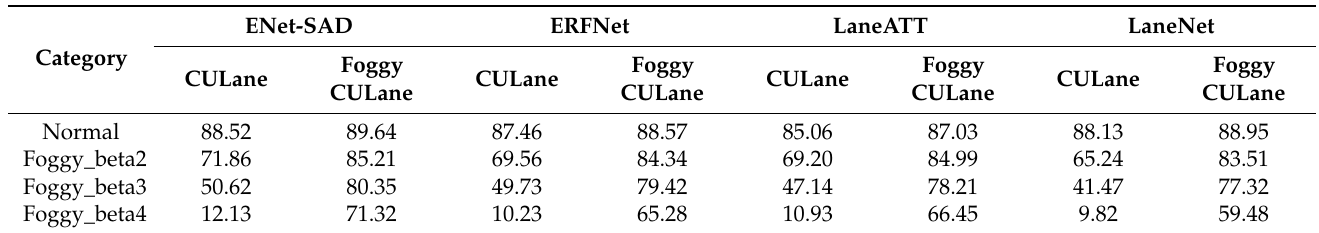
Table 4. Evaluation results (F1-measure) of other lane detection models, trained with CULane and FoggyCULane ( β = 2, 3, 4),